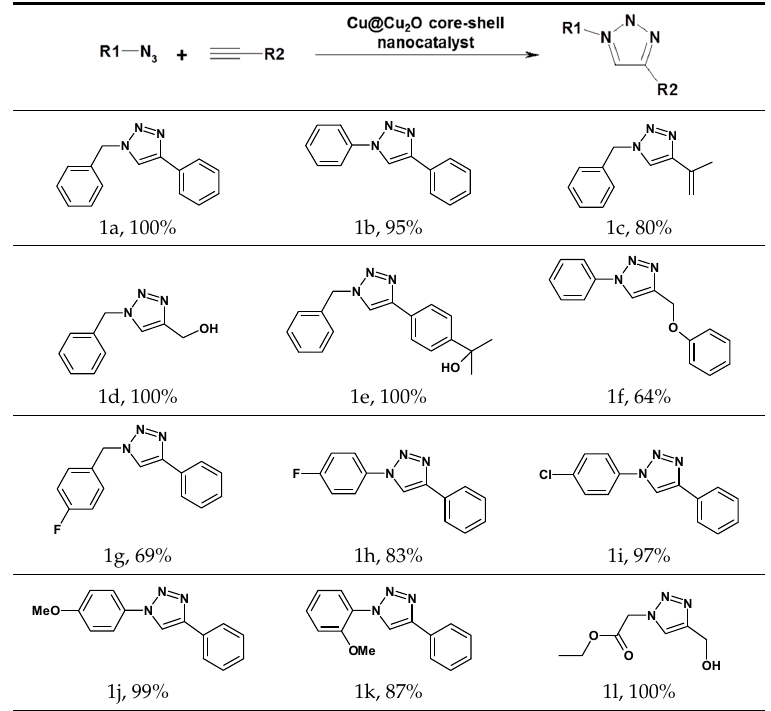
Table 1. Huisgen cycloaddition of azides with terminal alkynes catalyzed by Cu@Cu 2 O core-shell nanocatalyst 1 .